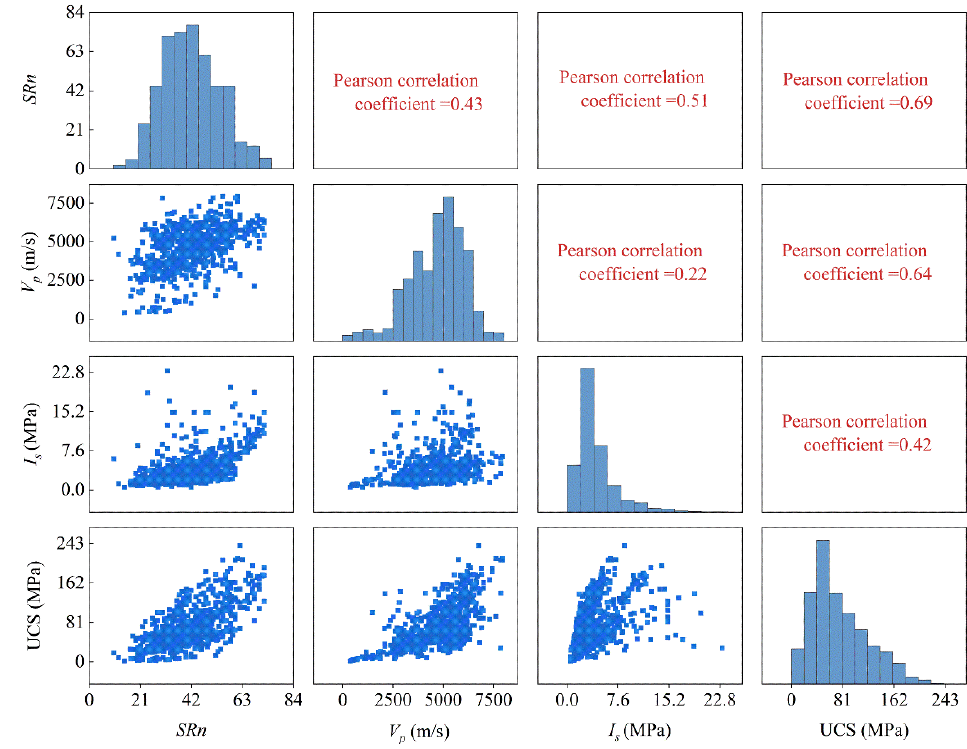
Figure 1. Visual illustration of the collected dataset.